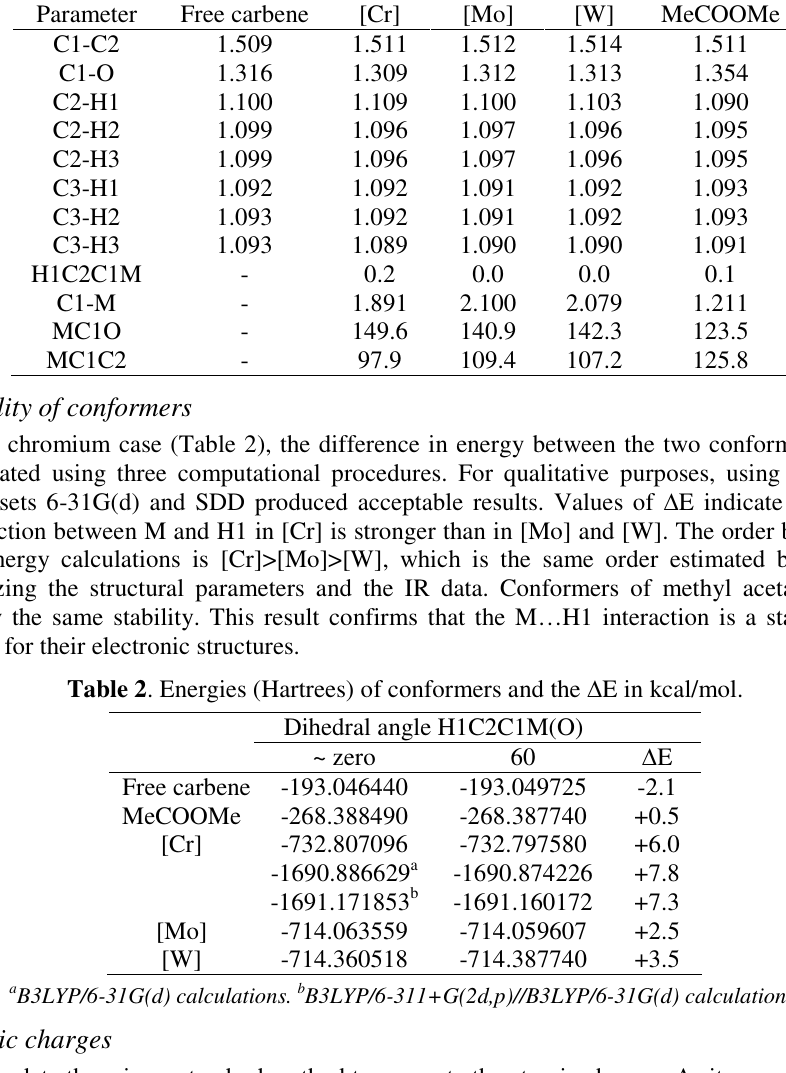
Table 1 . Selected bond lengths (Å) and angles (angles) for the five structures.